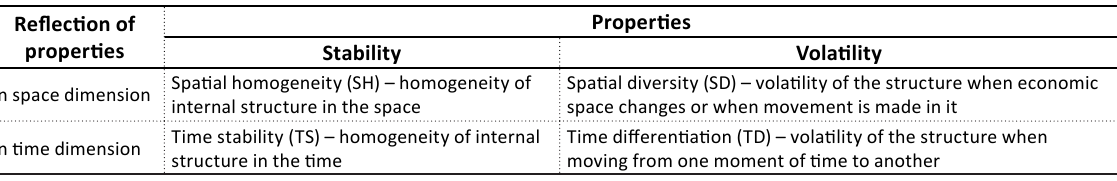
Table 2. Determination of peculiarities, which ensure the sustainability of the enterprise economic system